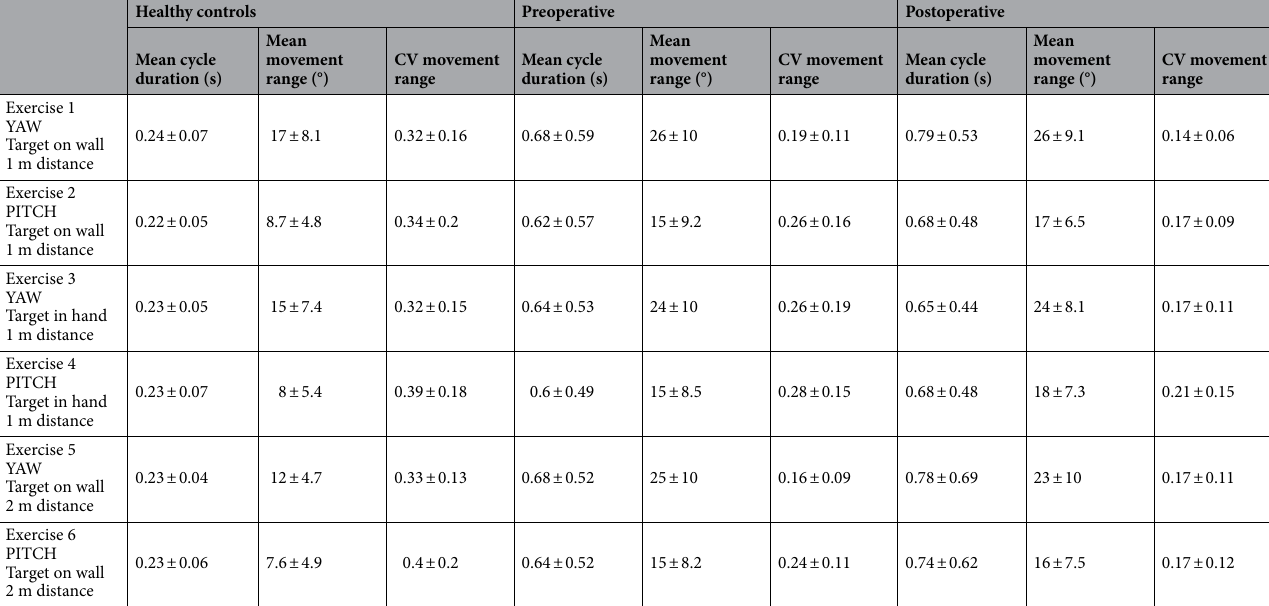
Table 2. Means ± SD of the six kinematic measures that demonstrated the most significant difference between vestibular patients (pre- and postoperative) and healthy controls. Each row corresponds a gaze stabilization